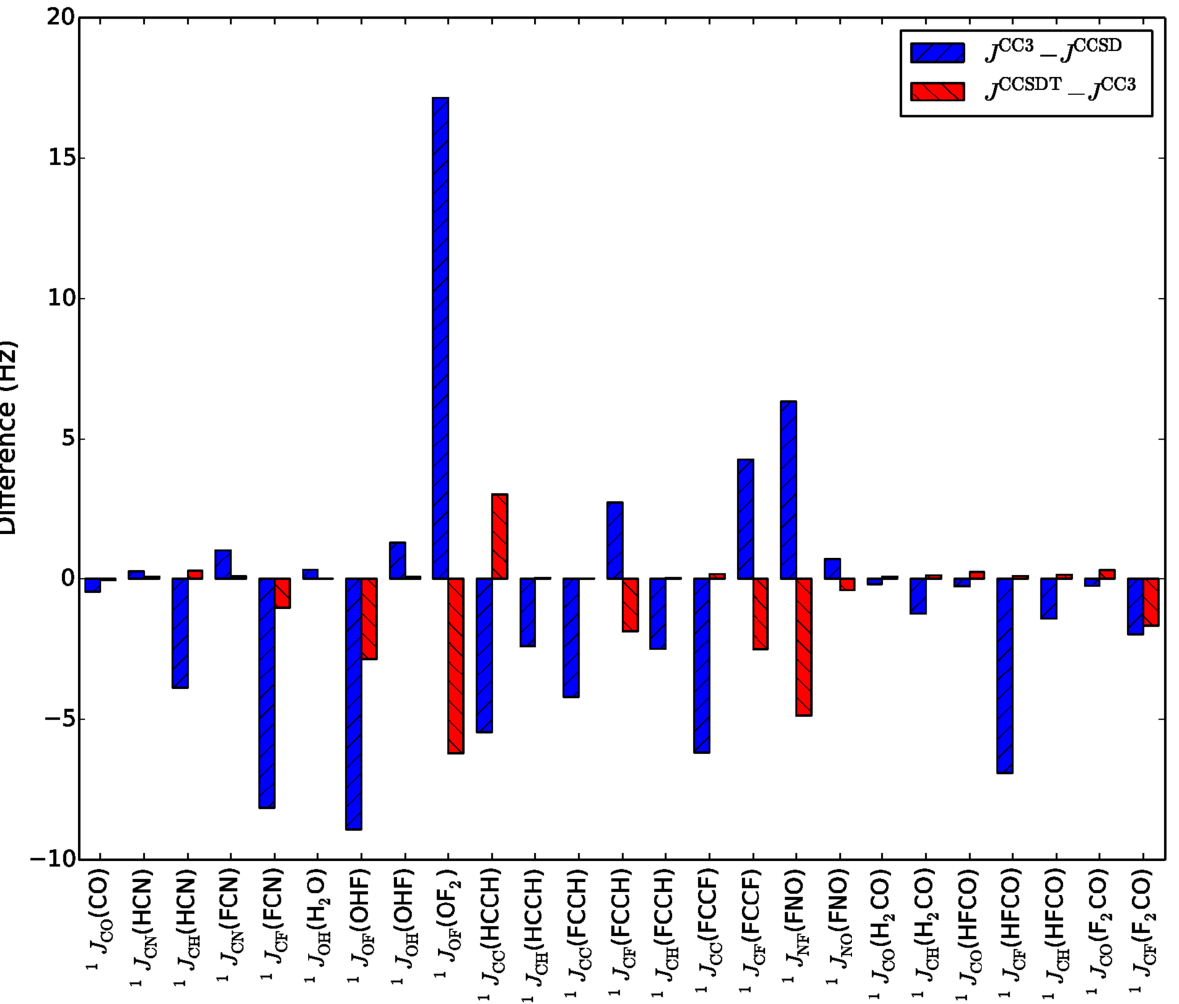
Figure 1. The CC3 triples correction (blue bars) and the residual triples correction (red bars) to various one-bond nuclear spin–spin coupling constants (in Hz). The CC3 corrections are calculated using aug-ccJ-pVTZ, whereas the residual corrections are calculated using the ccJ-pVDZ basis set. Reproduced from Ref. [254] with permission from American Chemical Society.